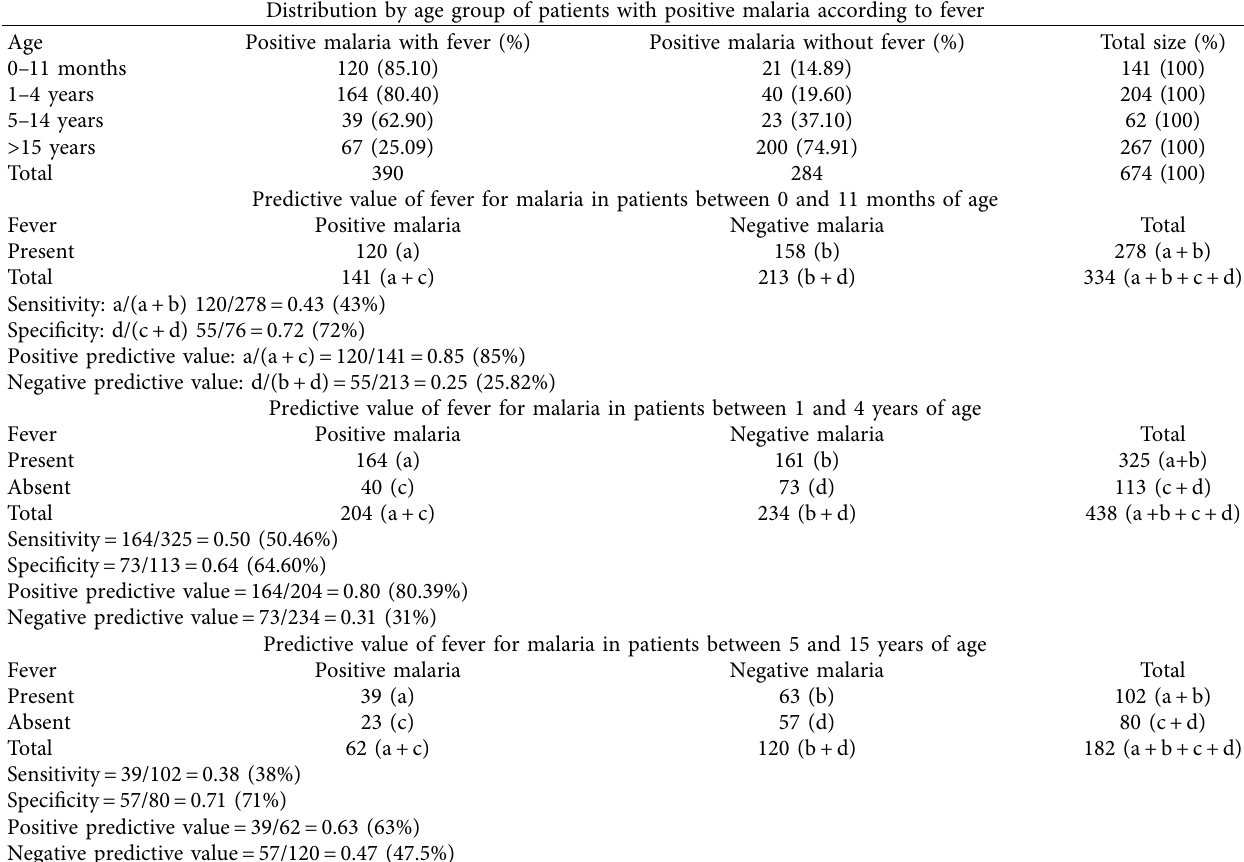
Table 3: Laboratory findings related to fever profile of the patients.